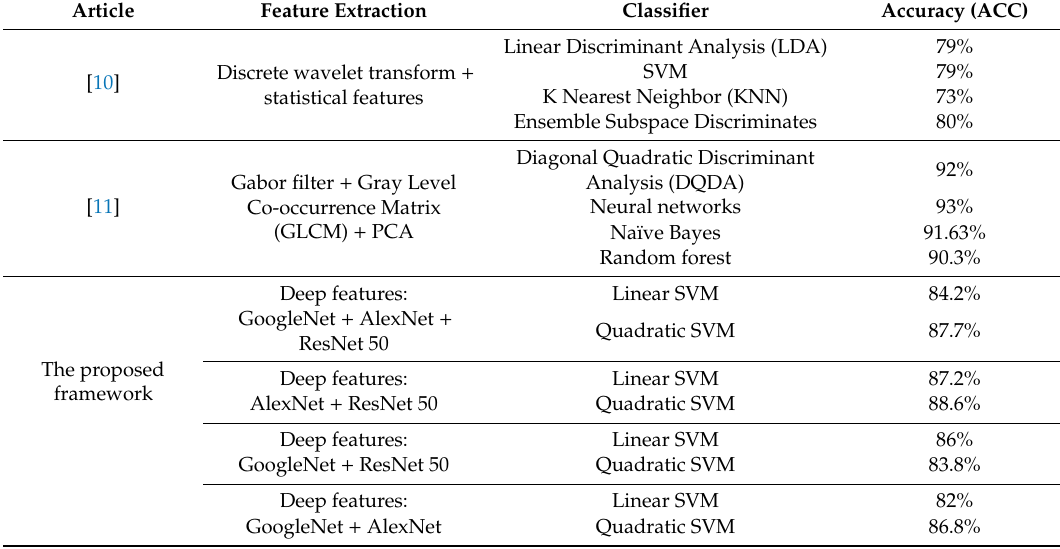
Table 7. A comparision between the accuracy of the proposed framework and recent related